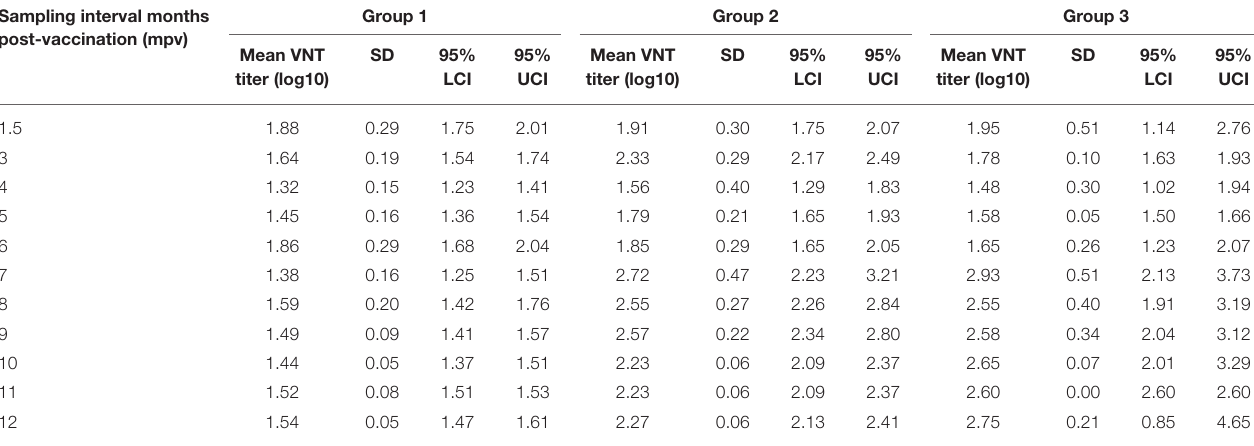
TABLE 6 | Comparison of antibody titers between the three vaccination groups at each post-vaccination-sampling interval. Sampling interval months post-vaccination